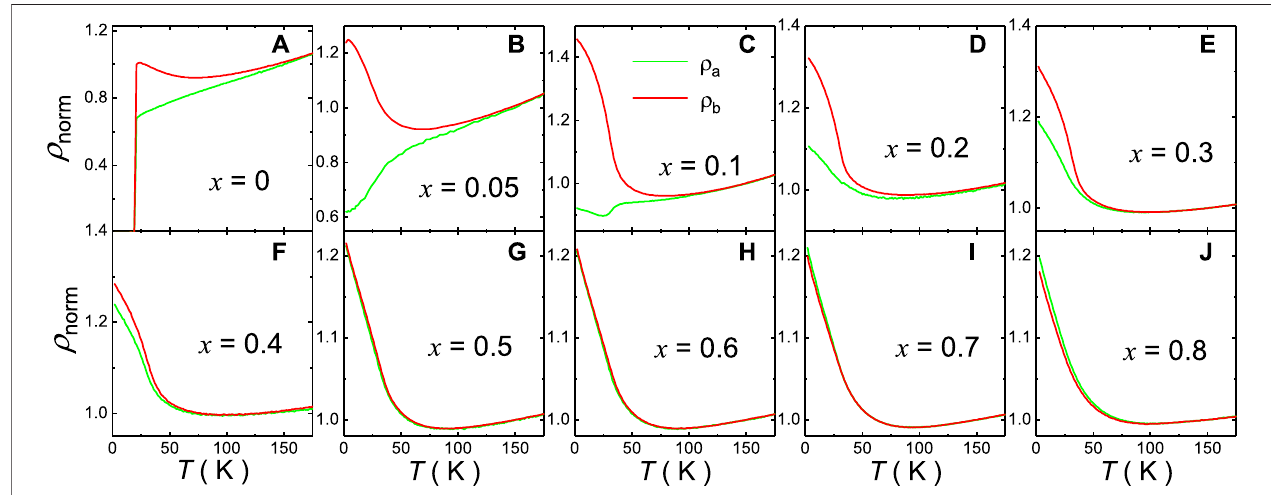
FIGURE 2 | (Color online) In-plane resistivity anisotropy of BaFe 1.9 − x Ni 0.1 Cr x As 2 under uniaxial pressure. Here, ρ b is the in-plane resistivity along the direction of uniaxial pressure, and ρ a is the in-plane resistivity perpendicular to the direction of uniaxial pressure. For easy comparison, each curve is normalized by its resistivity at 150 K, and there is no resistivity anisotropy above this temperature.